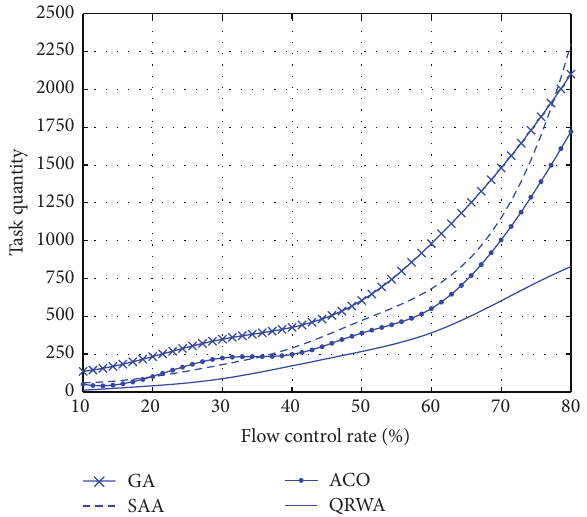
Figure 2: The flow control rate of SUN SPARC Enterprise T5120 in GA, SAA, ACO, and QRWA.